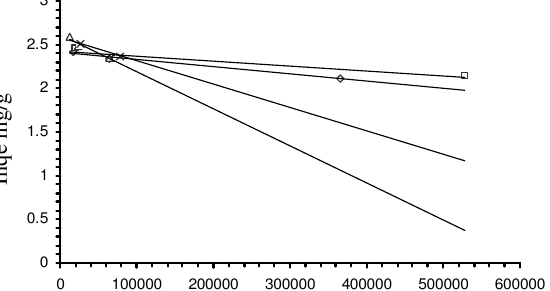
Figure 8. Tempkin plot for the adsorption of Cu(II) on to PFA, 2g/L, at different temperatures.